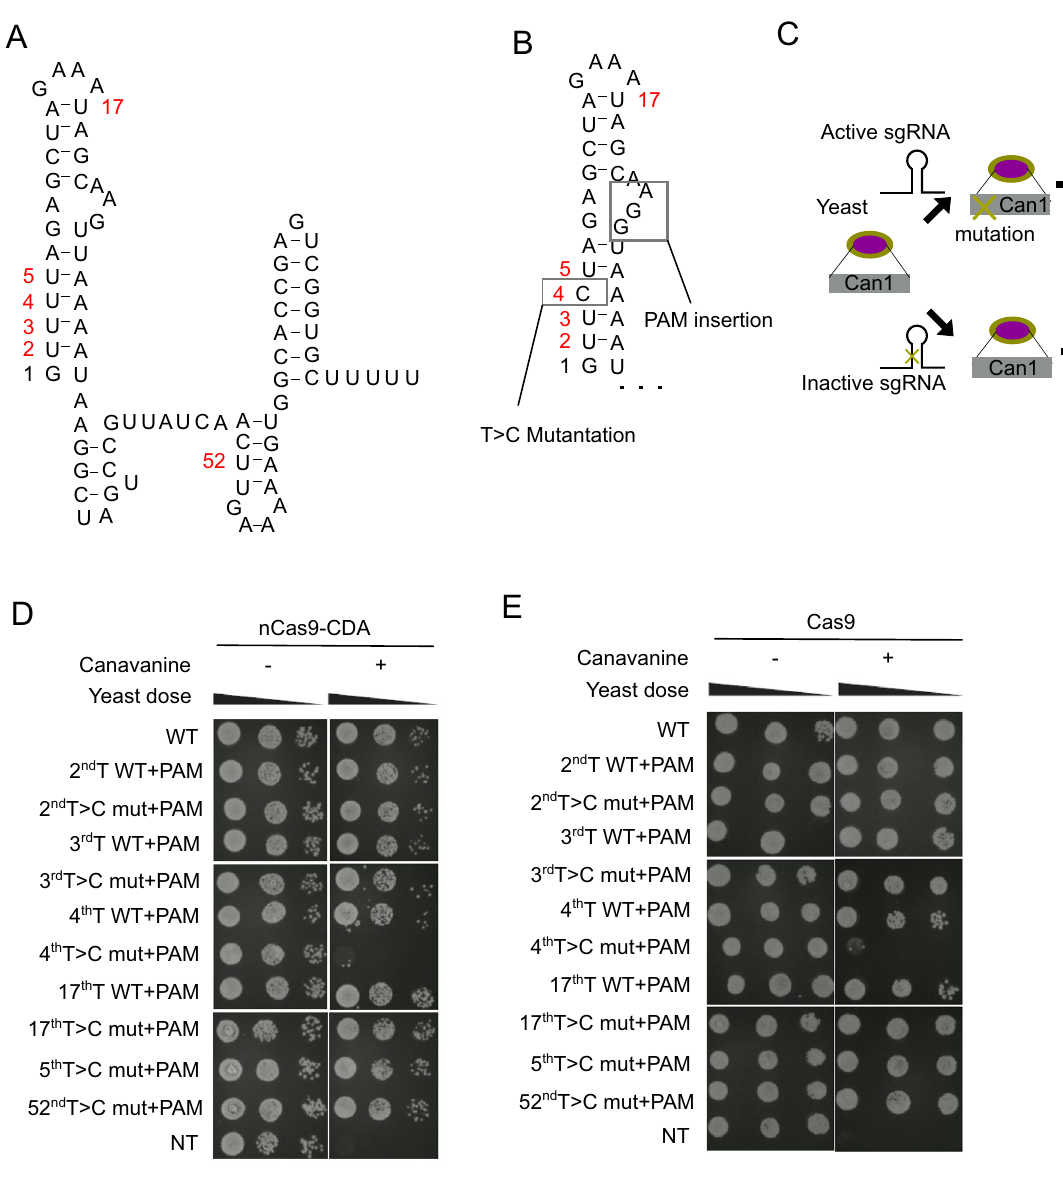
Figure 2. Screening of inactive sgRNAs with scaffold mutations in yeast. ( A ) Schematic representation of the scaffold region of sgRNAs. ( B ) Schematic representation of part of the scaffold region of sgRNAs with T > C mutations and PAM insertion. ( C – E ) Schematic representation ( C ) and results of the canavanine assay with nCas9-CDA ( D ) or Cas9 ( E ). Yeasts transduced with the indicated sgRNA were grown on plates with (right column) or without (left column)